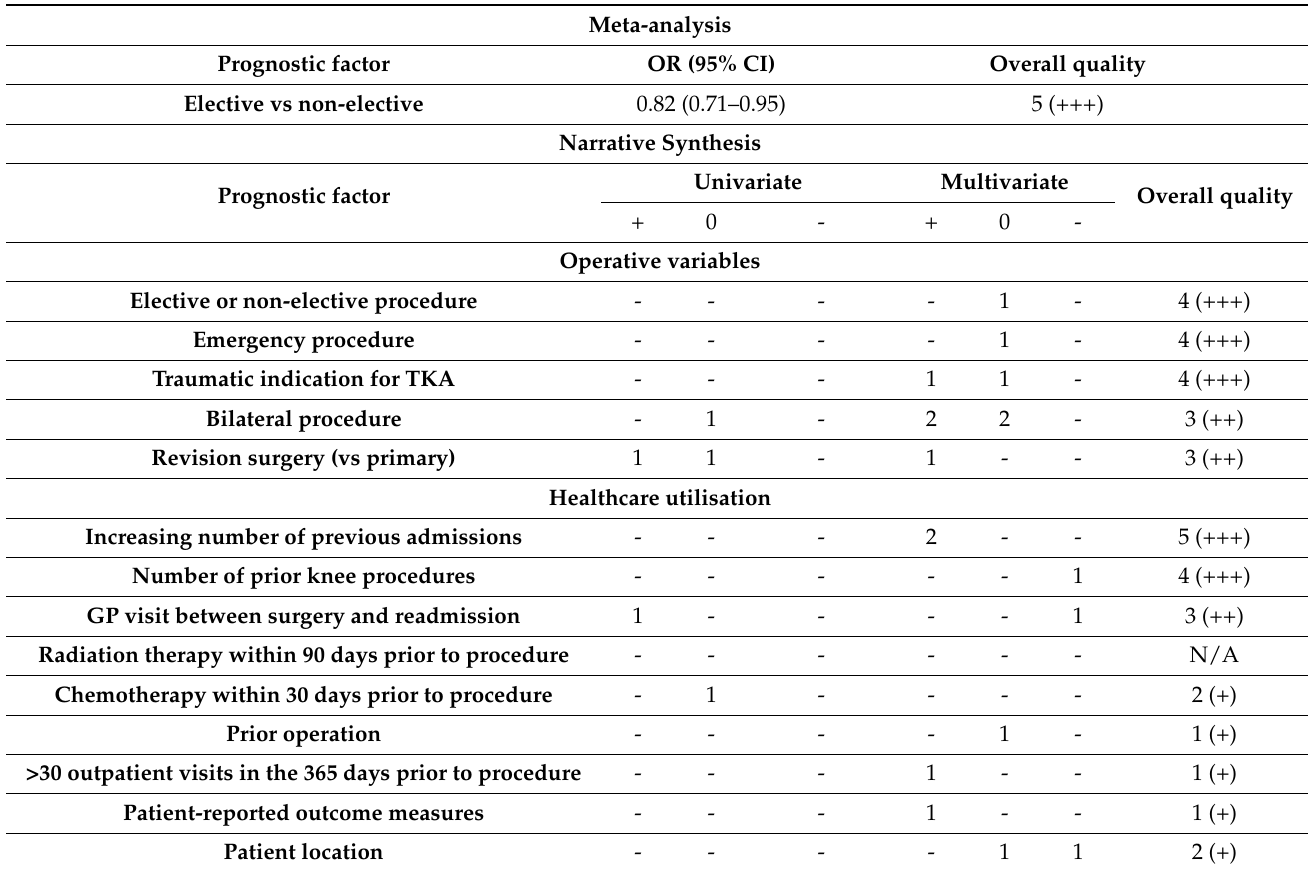
Table 6. Summary of